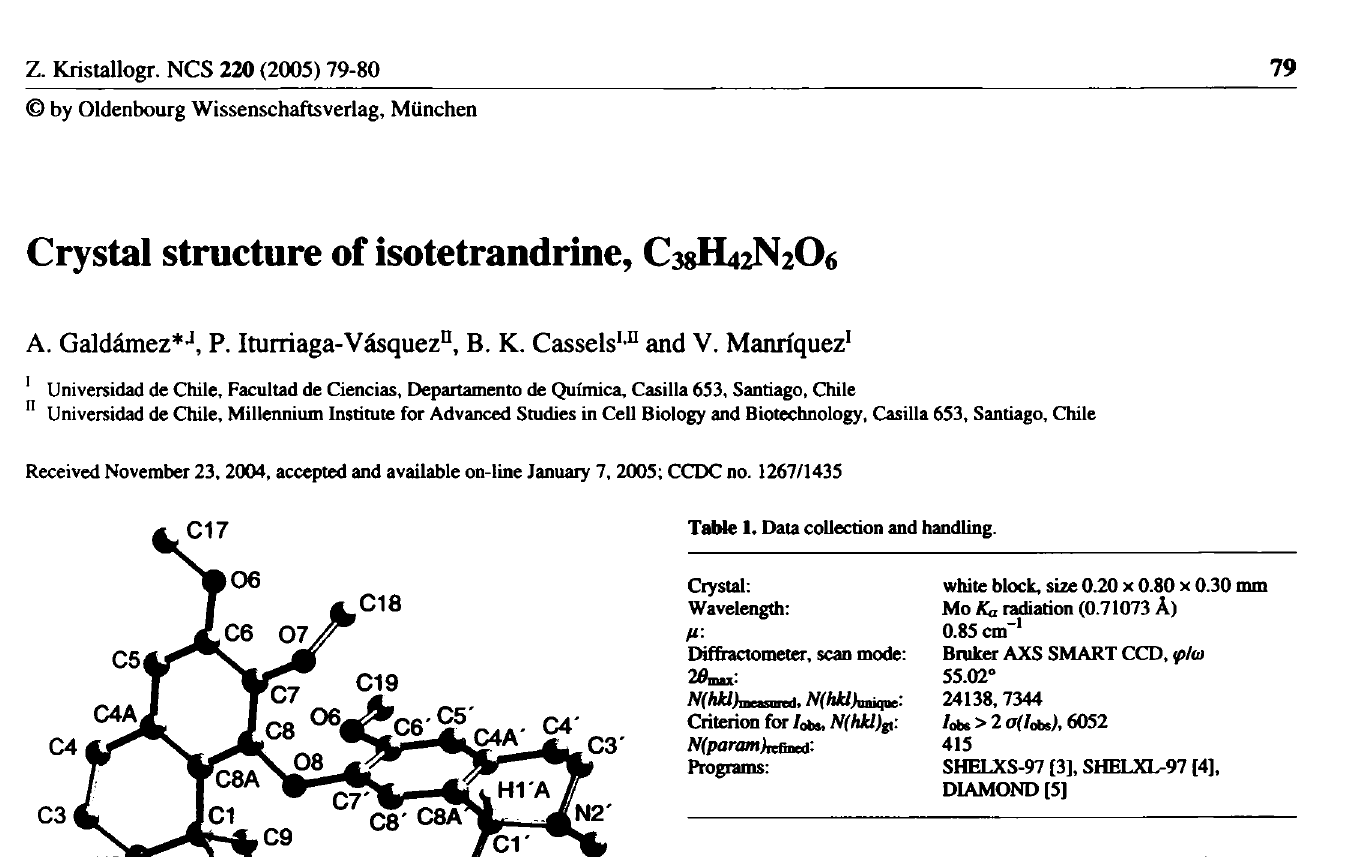
Table 2. Atomic coordinates and displacement parameters (in A 2